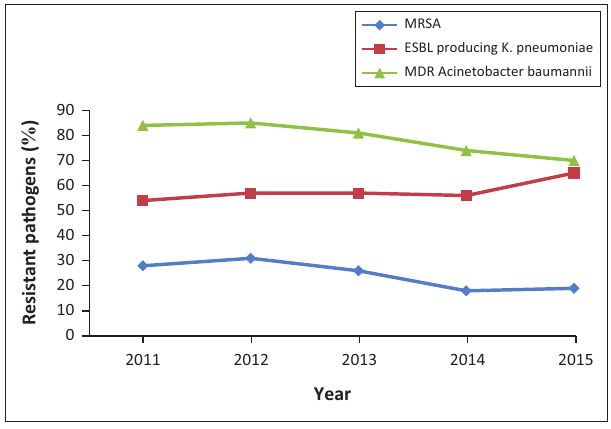
FIGURE 3: Resistance profile of P. aeruginosa (2011–2015).